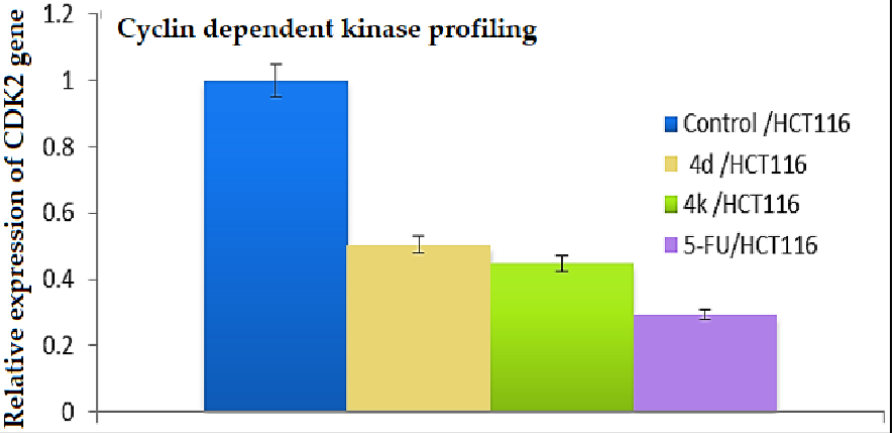
Figure 18. The expression profiles of the CDK2 gene in the lysate of HCT-116 cancer cells treated with compounds 4d and 4k .